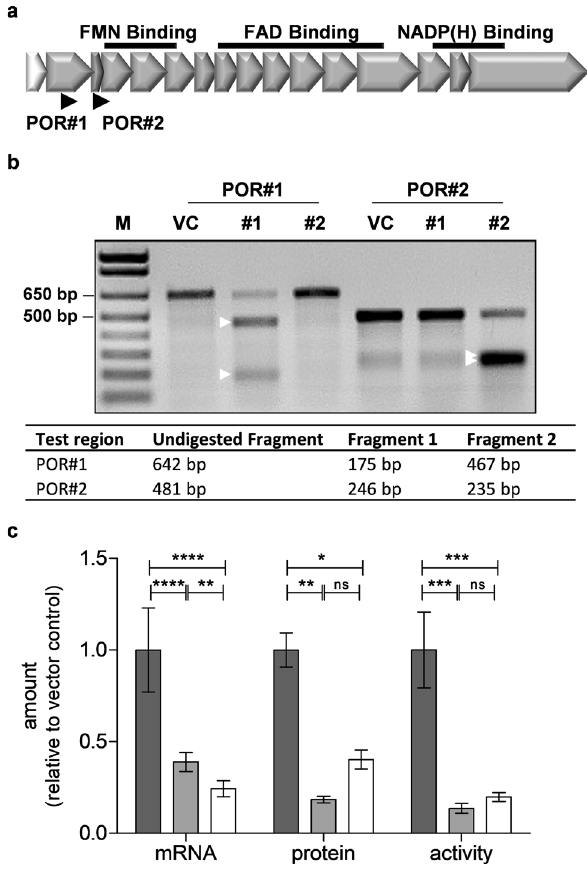
Figure 2. Validation of genetic POR -knockout in transduced HepaRG cells. ( a ) Location of POR -targeting gRNAs relative to exon structure (gene chr7:75,899,200–75,986,855) indicating one 5 ′ -untranslated exon (white) and 15 translated exons as well as binding regions (black) for FAD, FMN, and NADPH. The positions of two sgRNAs targeting exon 2 (POR#1) or the FMN binding site in exon 4 (POR#2) are indicated by arrows. ( b ) T7E1 digest of DNA of transduced HepaRG cells. M: DNA marker; lanes 2–4: digest products of test region POR#1; lanes 5–7: digest products of test region POR#2; VC: vector control; #1: sgRNA POR#1; #2: sgRNA POR#2. Digested fragments are marked with white arrows. The expected fragment sizes are summarized below. ( c ) POR expression and cytochrome c reductase activity in transduced differentiated HepaRG cells. POR mRNA was quantified in cell lysates and POR protein and cytochrome c reductase activity were quantified in microsomes. Mean levels ± SD are shown relative to vector control (VC) set at 1 (dark grey: VC, light grey: POR#1, white: POR#2). Statistical significance was assessed by unpaired t-test (* p < 0.05, ** p < 0.01, *** p < 0.001, **** p < 0.0001; ns, not